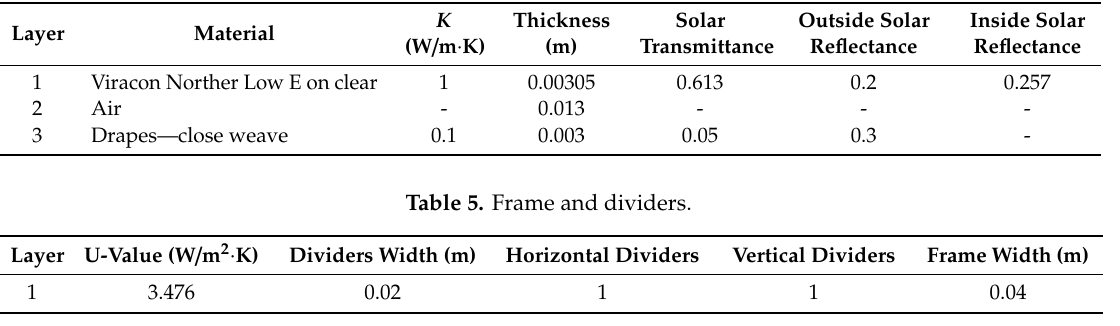
Table 5. Frame and dividers.